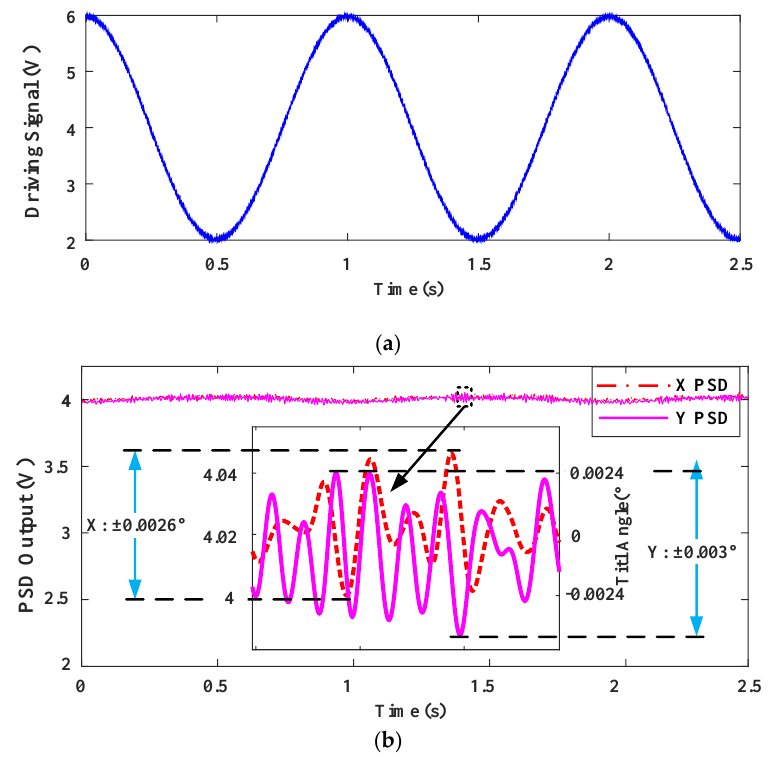
Figure 13. Measured tilt angle responses for PID FTS system. ( a ) Driving Signal. ( b ) PSD signals of X and Y two directions.